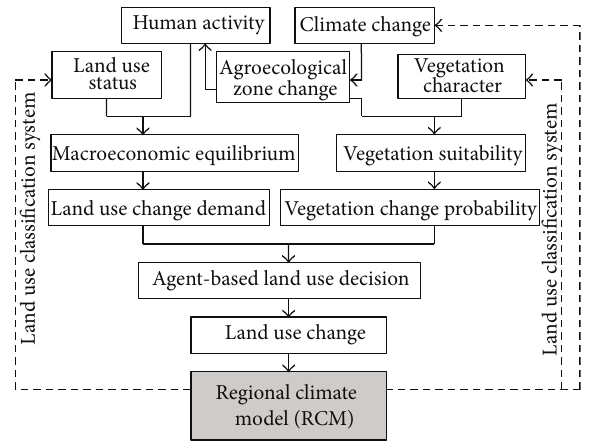
Figure 1: Framework of feeding LUCC model results into RCMs simulation.